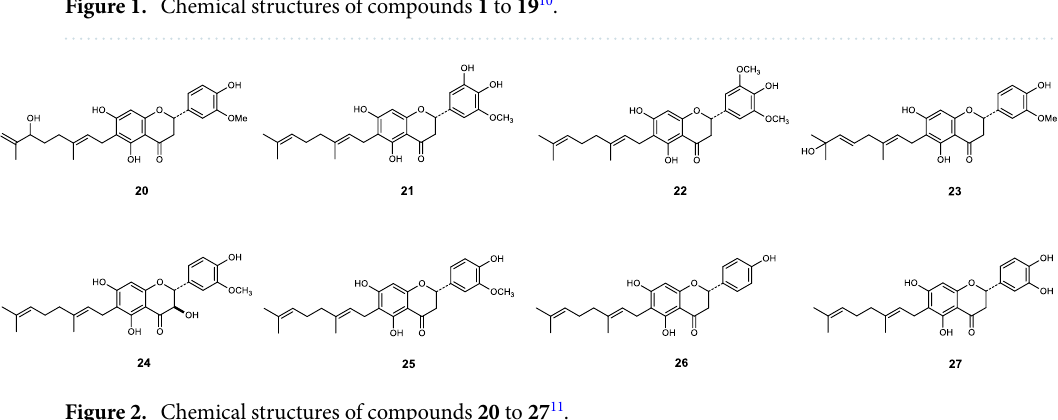
Figure 2. Chemical structures of compounds 20 to 27 11